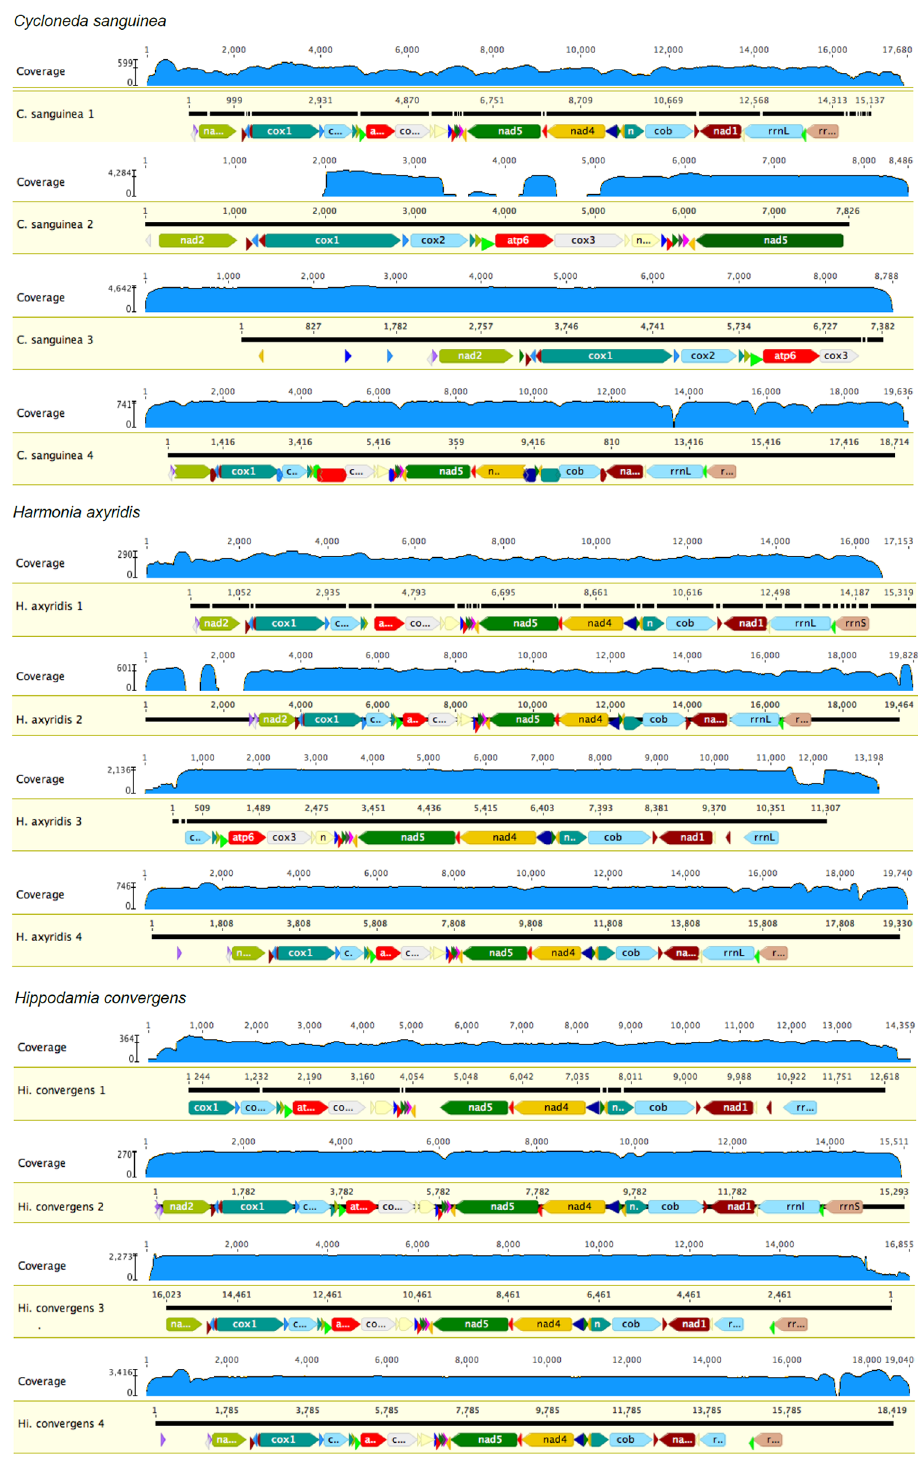
Fig 2. Coverage of the mitogenomes obtained for each species using the four methods. The minimum and maximum (presentedin log-scale) is indicatedon the ordinateof each figure and the coveragefor each nucleotide position is indicatedby the height of the blue line. The black bar represents the consensus nucleotide sequenceand horizontalthin lines represent gaps. In each figure, the number after the species mitogenome name indicatesthe method used to assembleand